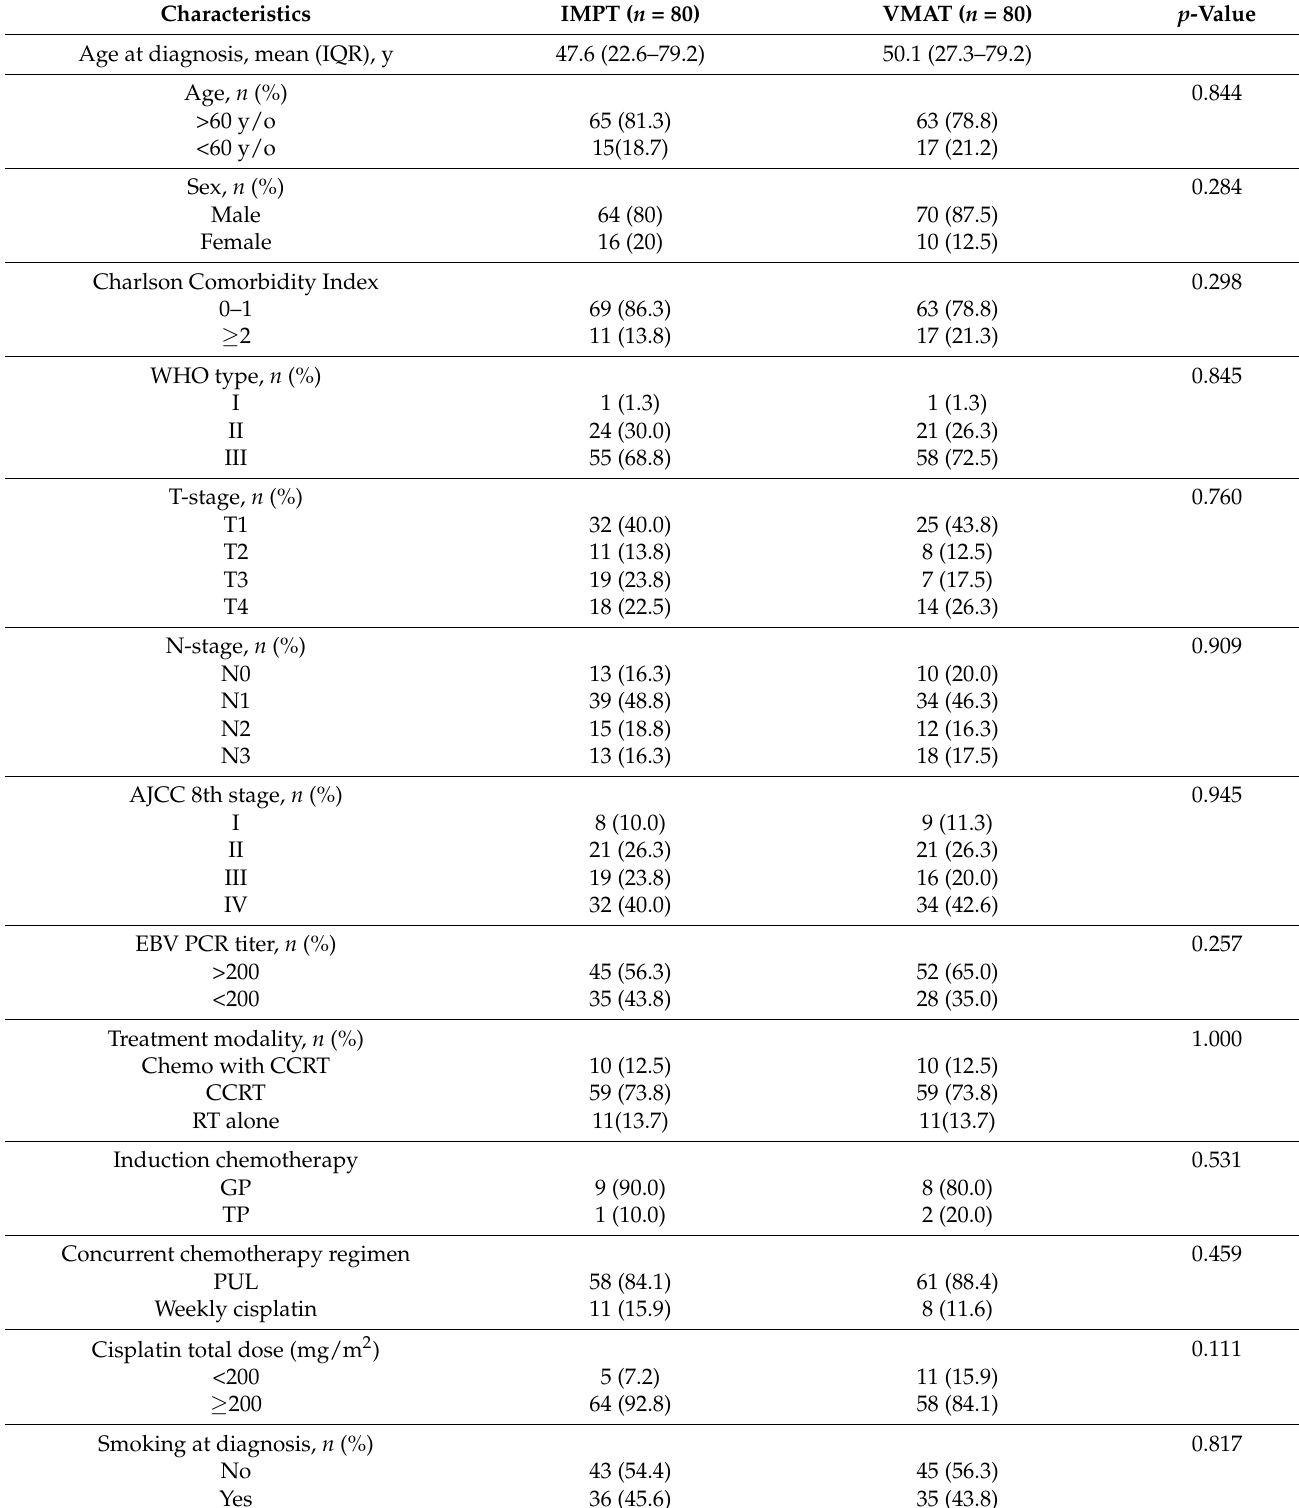
Table 1. Comparison between characteristics of patients with NPC treated using IMPT and